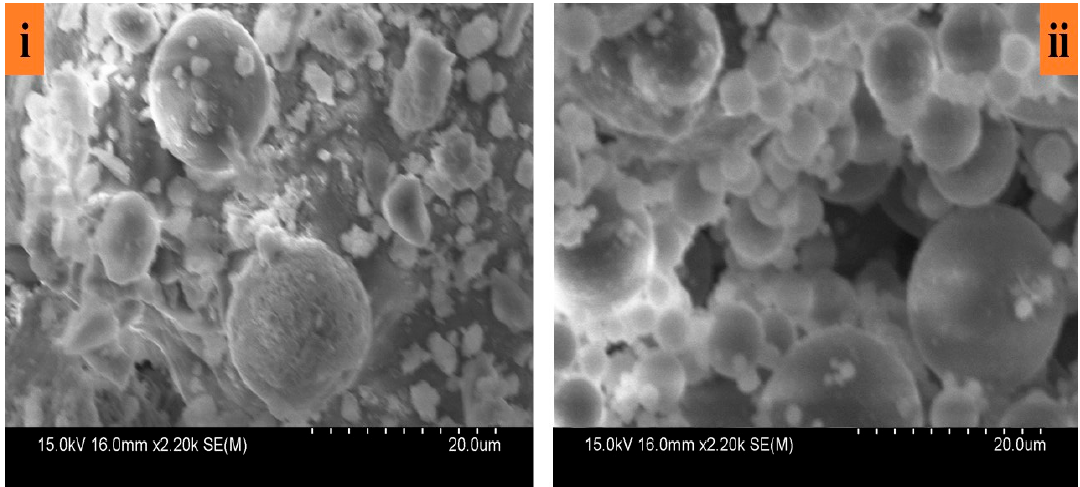
Figure 1. SEM images of ( i ) bottom-ash ( ii ) fly-ash.